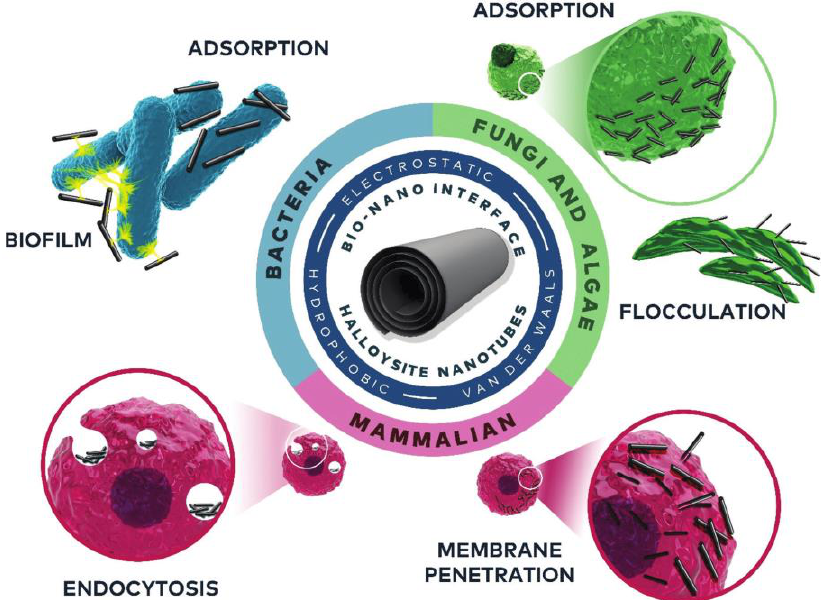
Figure 6. A scheme of the nano–bio interface of HNTs and cells along with the relevant mechanisms and interactions. Reproduced with permission from [36].